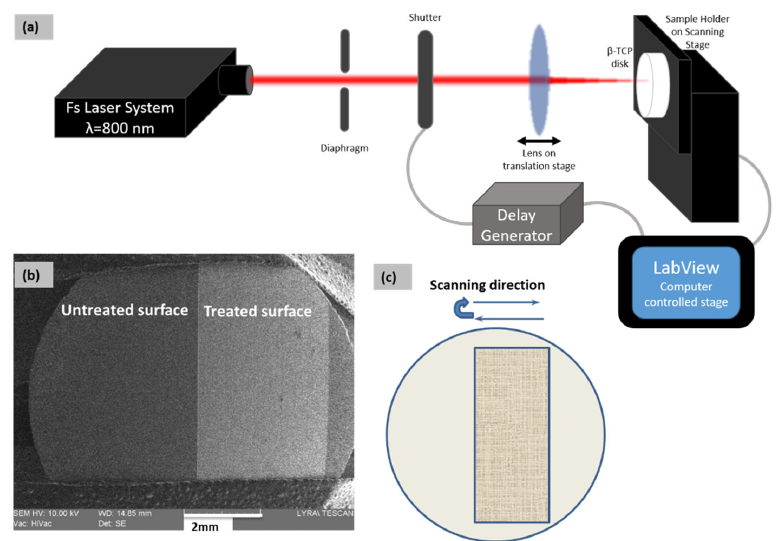
Figure 1. Experimental setup for femtosecond laser irradiation of β -tricalcium phosphate ( β -TCP) discs: ( a ) scheme of the setup for fs-laser microprocessing; ( b ) optical image of irradiation geometry on the pellet surface; ( c ) scanning direction of the laser beam on the surface of the β -TCP disc.